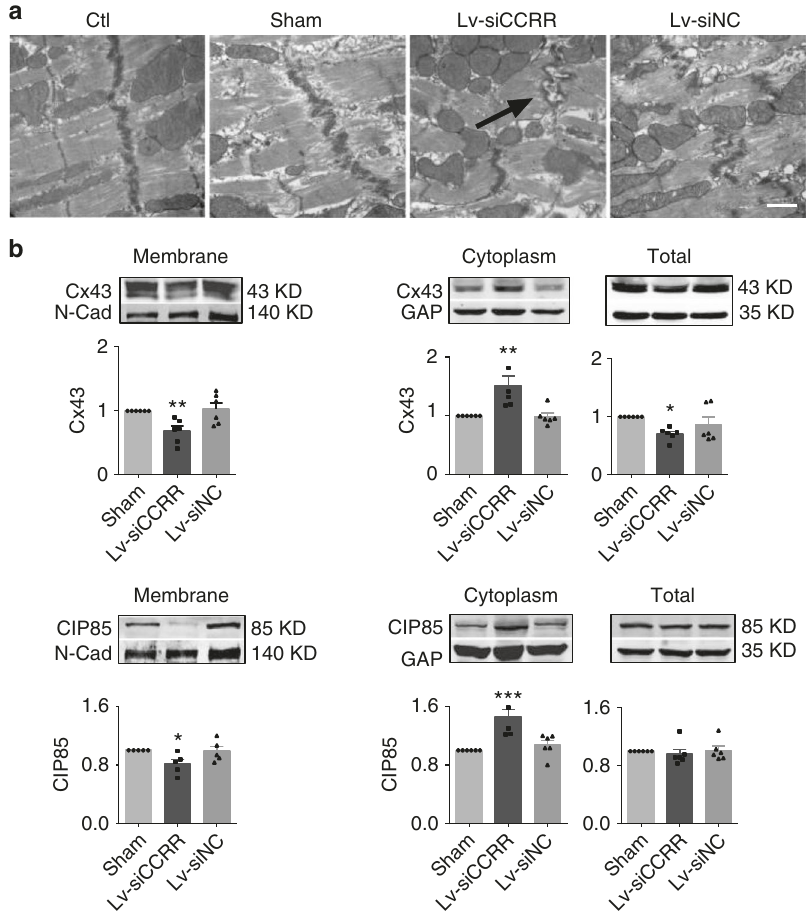
Fig. 4 CCRR knockdown causes destruction of intercalated discs and gap junction in healthy mice. a Representative images of electron microscopy (30,000× magni fi cation) showing the effects of knockdown of endogenous CCRR by Lv-siCCRR on the microstructure of left ventricular cardiac muscles in healthy mice. Note the profound derangement and loss of intercalated discs in the hearts pretreated with Lv-siCCRR (dark arrows), resembling those noted in HF heart, which was not observed with Lv-siNC and Sham-Control (subjected to the surgical procedures but without lentivirus injection). Similar results were observed in another three independent experiments. b Effects of CCRR knockdown by Lv-siCCRR on the protein levels of Cx43 (left panel) and CIP85 (right panel) in healthy mice, with comparisons between the membrane and cytoplasm fractions. Lv-siCCRR elicited similar alterations of Cx43 and CIP85 levels in normal hearts as those seen above with HF hearts. Cx43 was decreased in the membrane fraction, but increased in the cytoplasm, with a net reduction of total protein levels. * P < 0.05, ** P < 0.01, *** P < 0.001 Lv-siCCRR vs. Sham; n = 6 mice for each group. CIP85 showed similar changes but with the total protein level unaffected. * P < 0.05, ** P < 0.01 Lv-siCCRR vs. Sham; n = 5 heart samples of membrane fraction for each group, n = 6 for cytoplasmic fraction, and n = 6 for total protein. (Mean ± SEM; ANOVA followed by Dunnett ’ s test for multiple group comparisons, and Student t test for two group